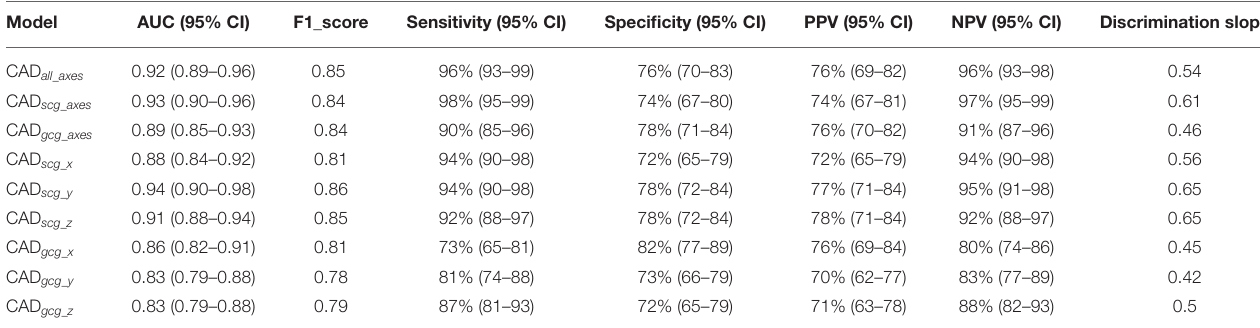
TABLE 1 | Overall classification performance for the 6-channel model (CAD all _ axes ), the 3-channel SCG (CAD scg _ axes ), the 3-channel GCG (CAD gcg _ axes ), three one-channel SCG (CAD scg _ x , CAD scg _ y , CAD scg _ z ), and three one-channel GCG (CAD gcg _ x , CAD gcg _ y , CAD gcg _ z